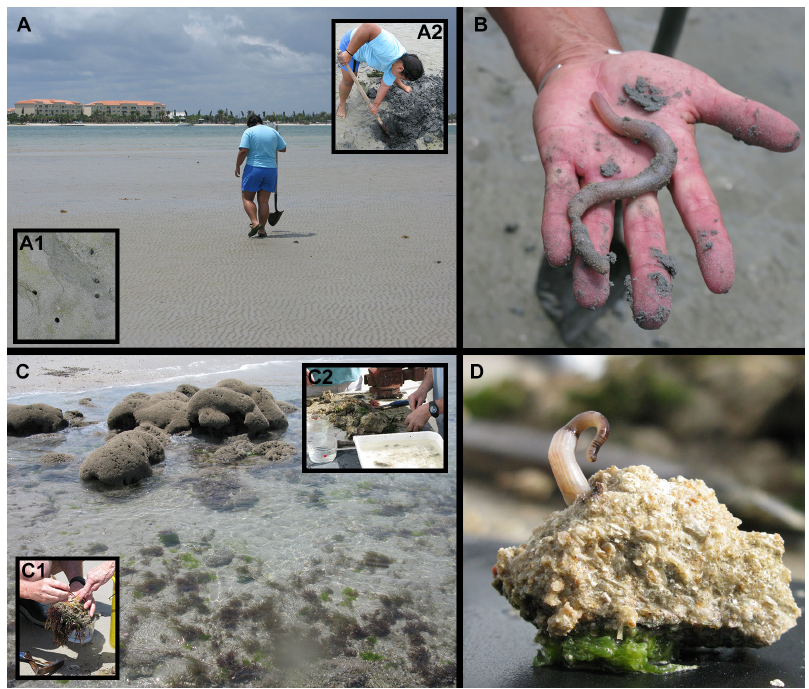
Figure 4. Collecting Sipuncula. ( A ) Sand bar exposed by low tide, habitat for large sipunculans; ( A1 ) Sipuncula holes; ( A2 ) Digging deep into the sediment searching for sipunculans; ( B ) Siphonosoma cumanenses found in this habitat; ( C ) Beach with sabellariid mounds exposed by low tide; ( C1 ) Pieces of polychaete colonies with sipunculans; ( C2 ) breaking the pieces of polychaete colonies searching for sipunculans; ( D ) Phascolosoma perlucens found living among the polychate